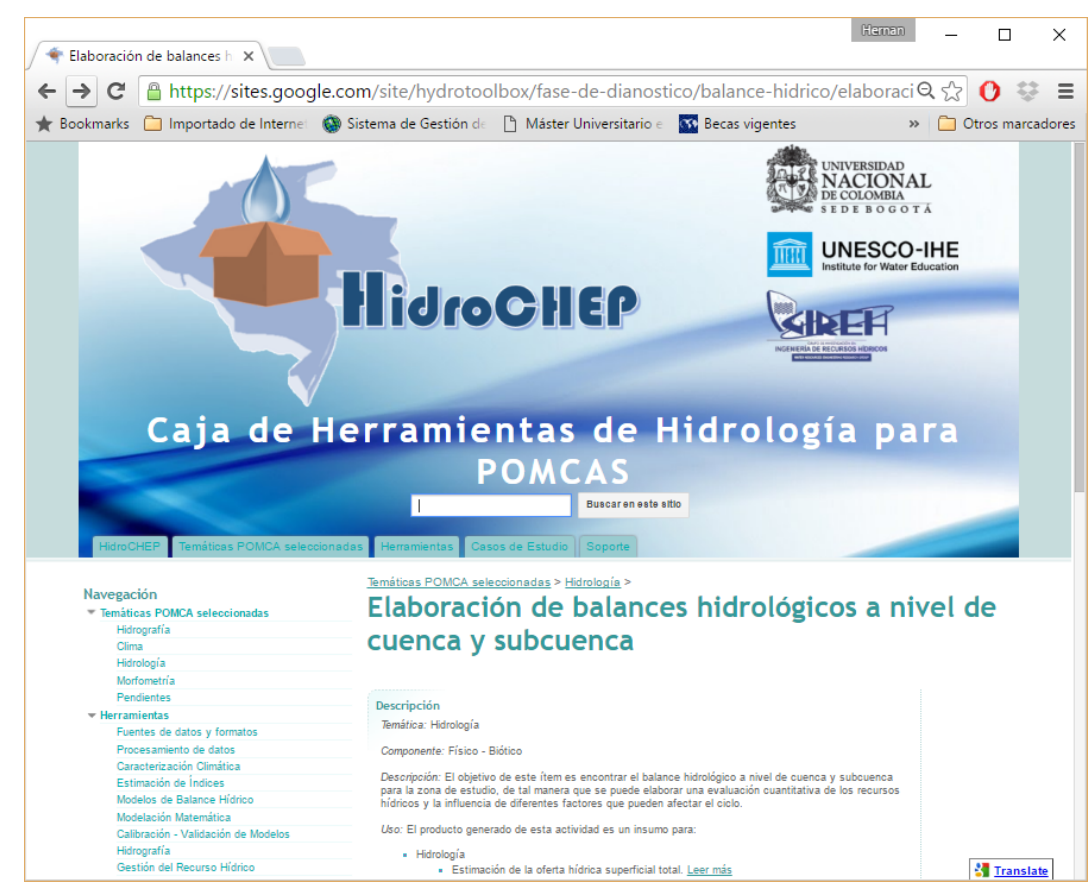
Figure 4. HidroCHEP interface showing a guide for a POMCA selected